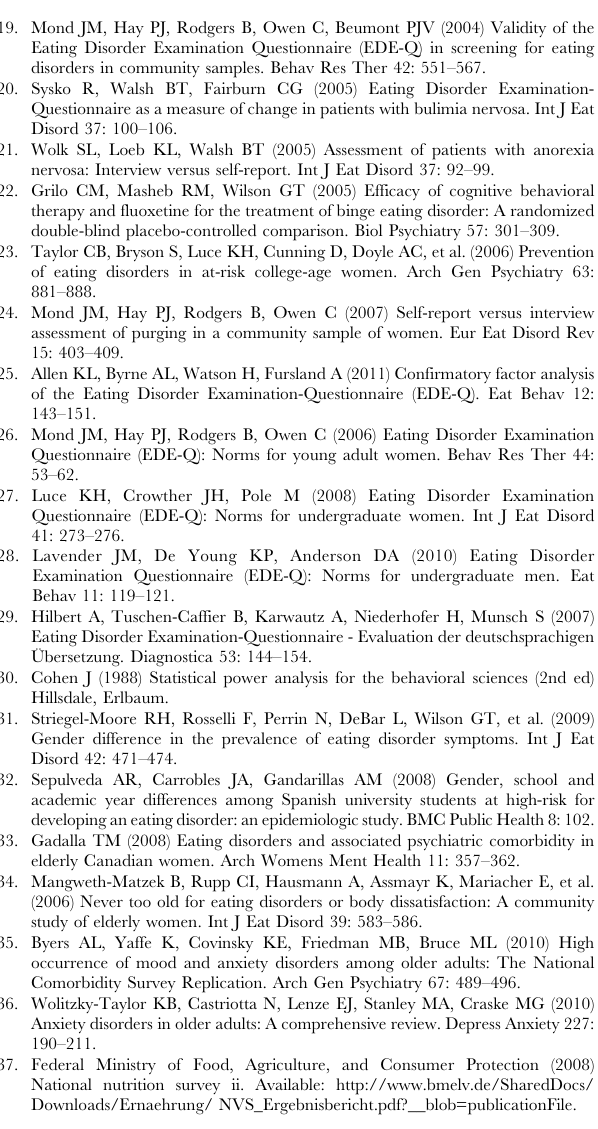
Table S3 Item Characteristics of the Eating Disorder Examina- tion-Questionnaire (N= 2520). Table S4 Principal Components Analysis of the Eating Disorder Examination-Questionnaire Items (N =